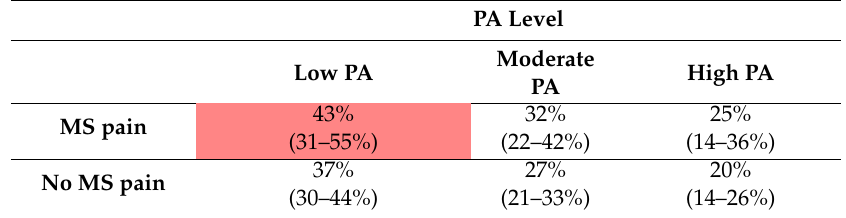
Table A3. Sensitivity analyses, risk matrix model for boys. Probability of Obesity (BMI ≥ 30) (percentage, (95% CI)) in young adulthood, with the reference group restricted to individuals within a normal weight range (BMI 18 · 5–24 · 9 kg / m 2